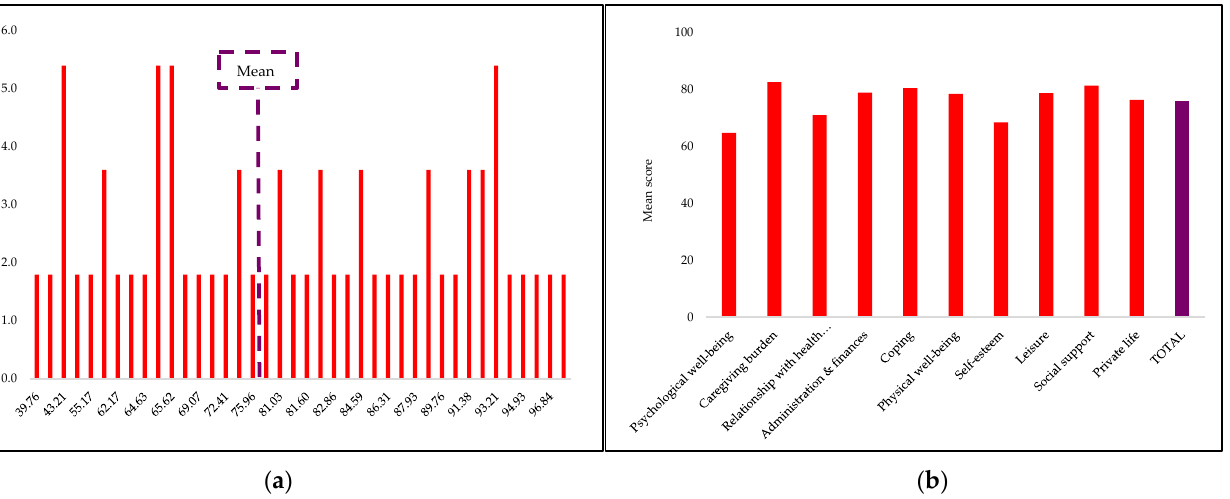
Figure 1. Oral cancer caregivers’ QOL scores. ( a ) Frequency of QOL scores (%); ( b ) M-CarGOQoL domains mean scores.